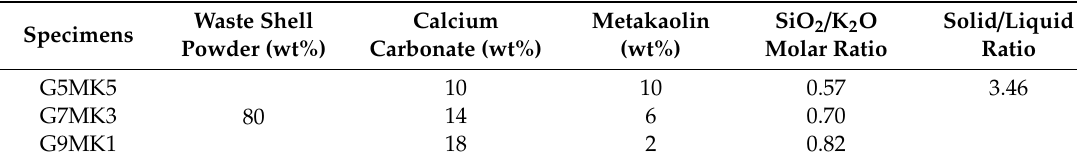
Table 2. Geopolymer slurry preparation design.